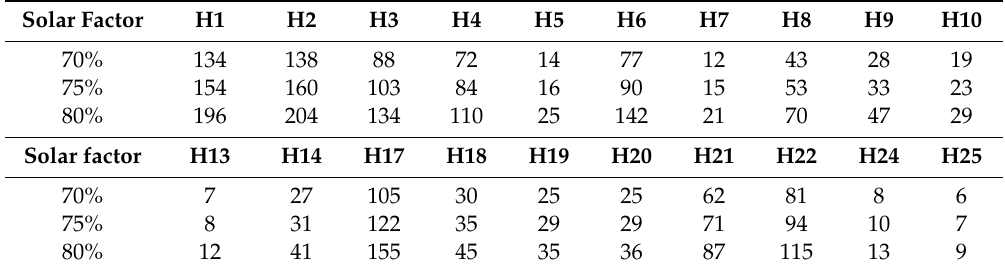
Table 3. Number of solar thermal collectors for each hospital according to the solar factor.